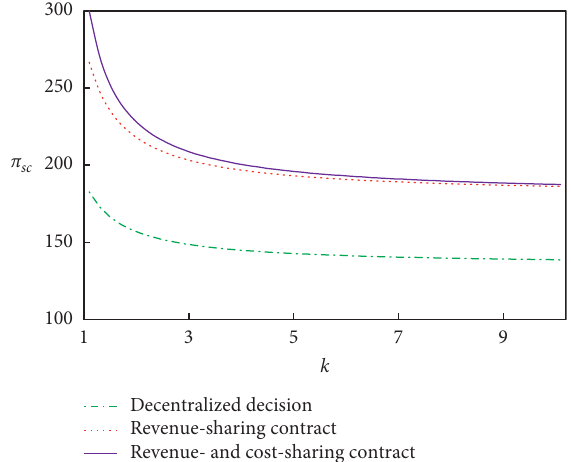
Figure 4: Impact of the safety input marginal cost coefficient on the supply chain’s